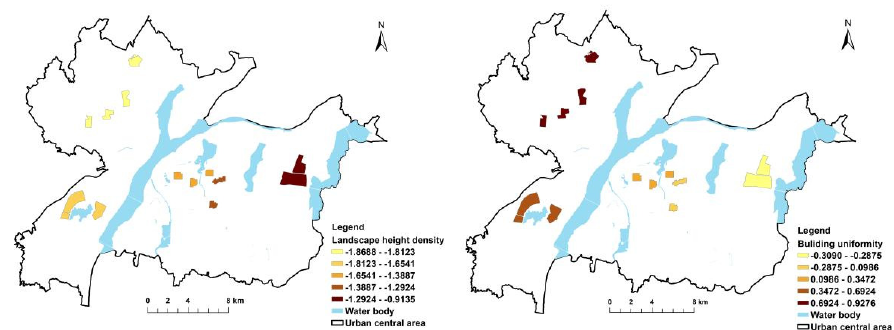
Figure 4. GWR results for educational function zone.